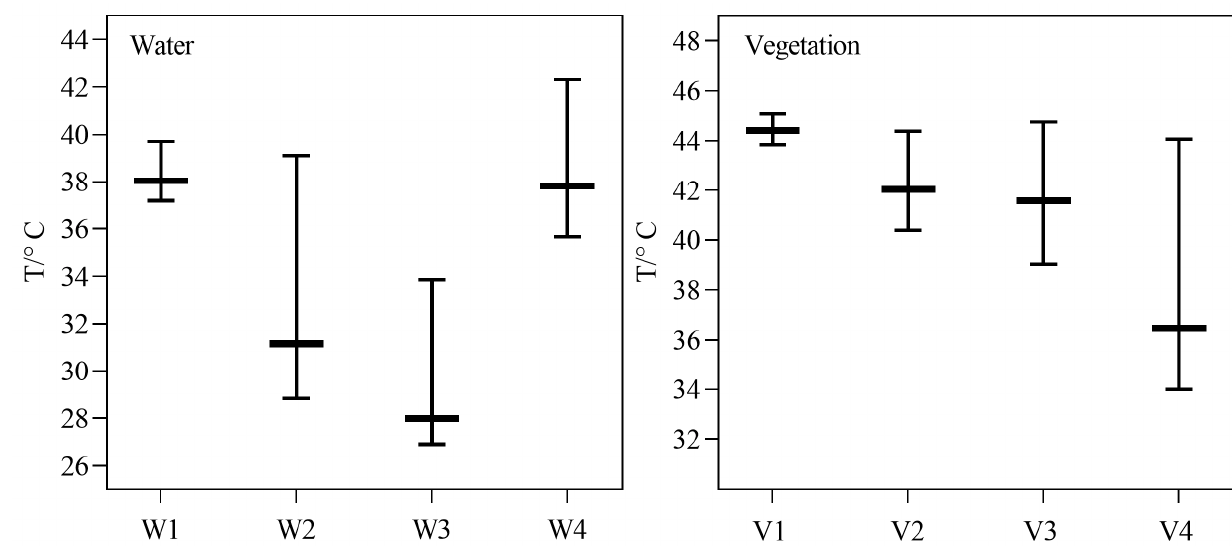
Figure 6. Temperature information of water and vegetation patch samples.